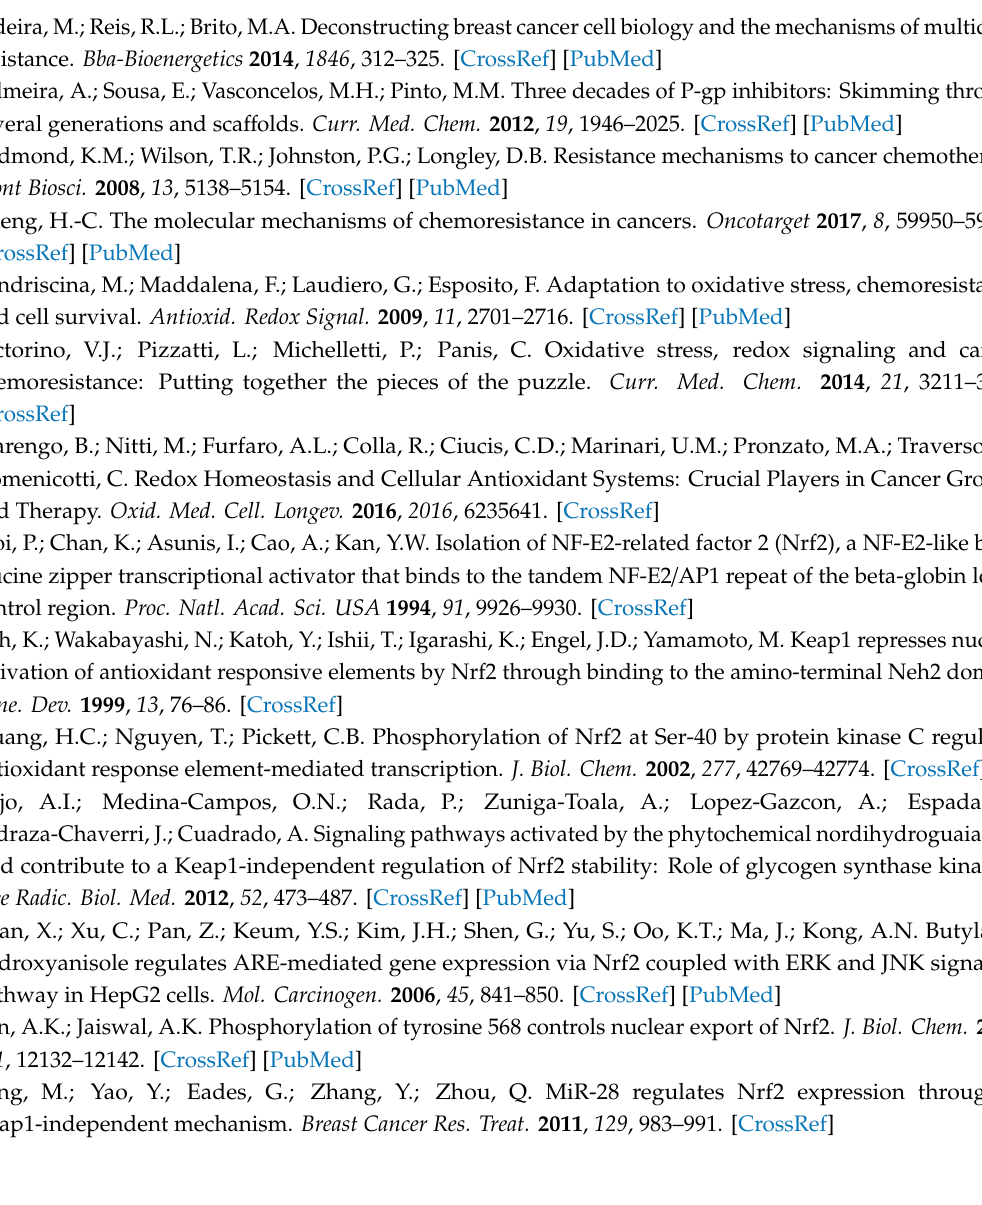
Table S2: Clinical characteristics of 124 cases of primary breast cancers analyzed in this study, Table S3: Clinical characteristics of 62 breast cancer patients with record of having received chemotherapeutic treatment analyzed in this